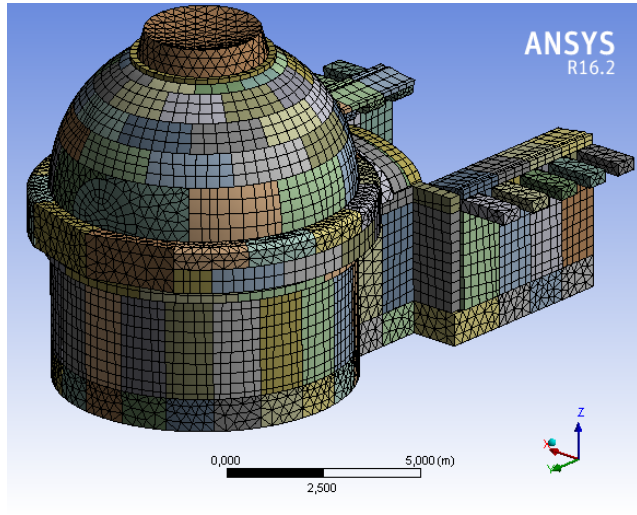
Figure 25. First test of meshing the structure. Source:.